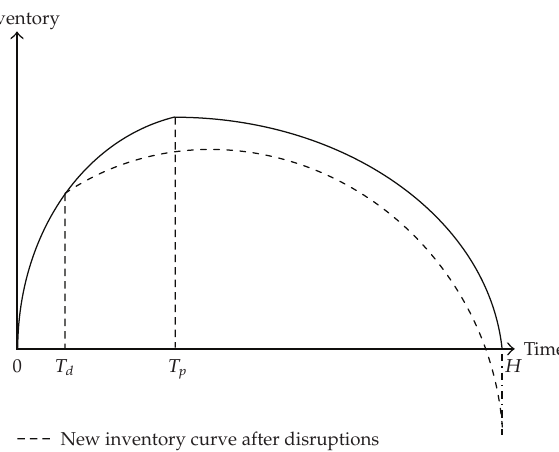
Figure 2: Inventory system with production